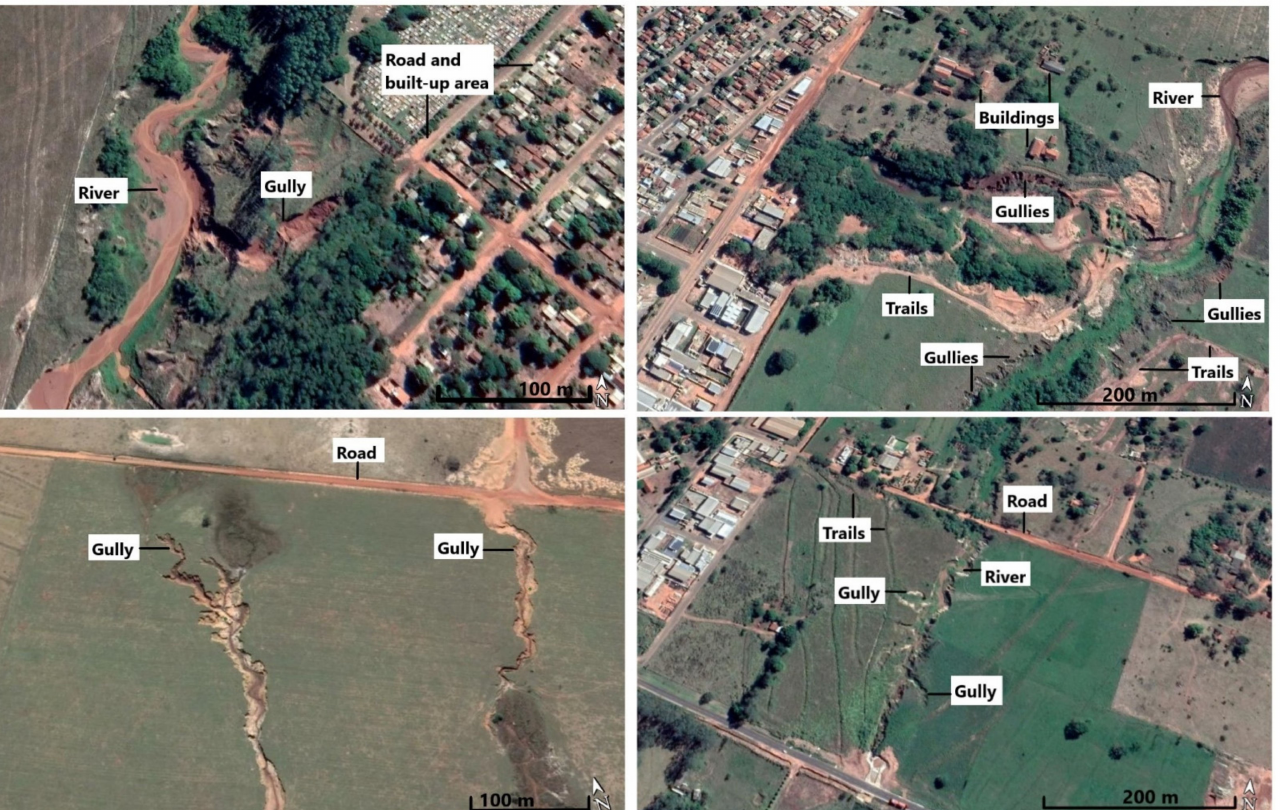
Figure 13. Examples of gullies affecting urban